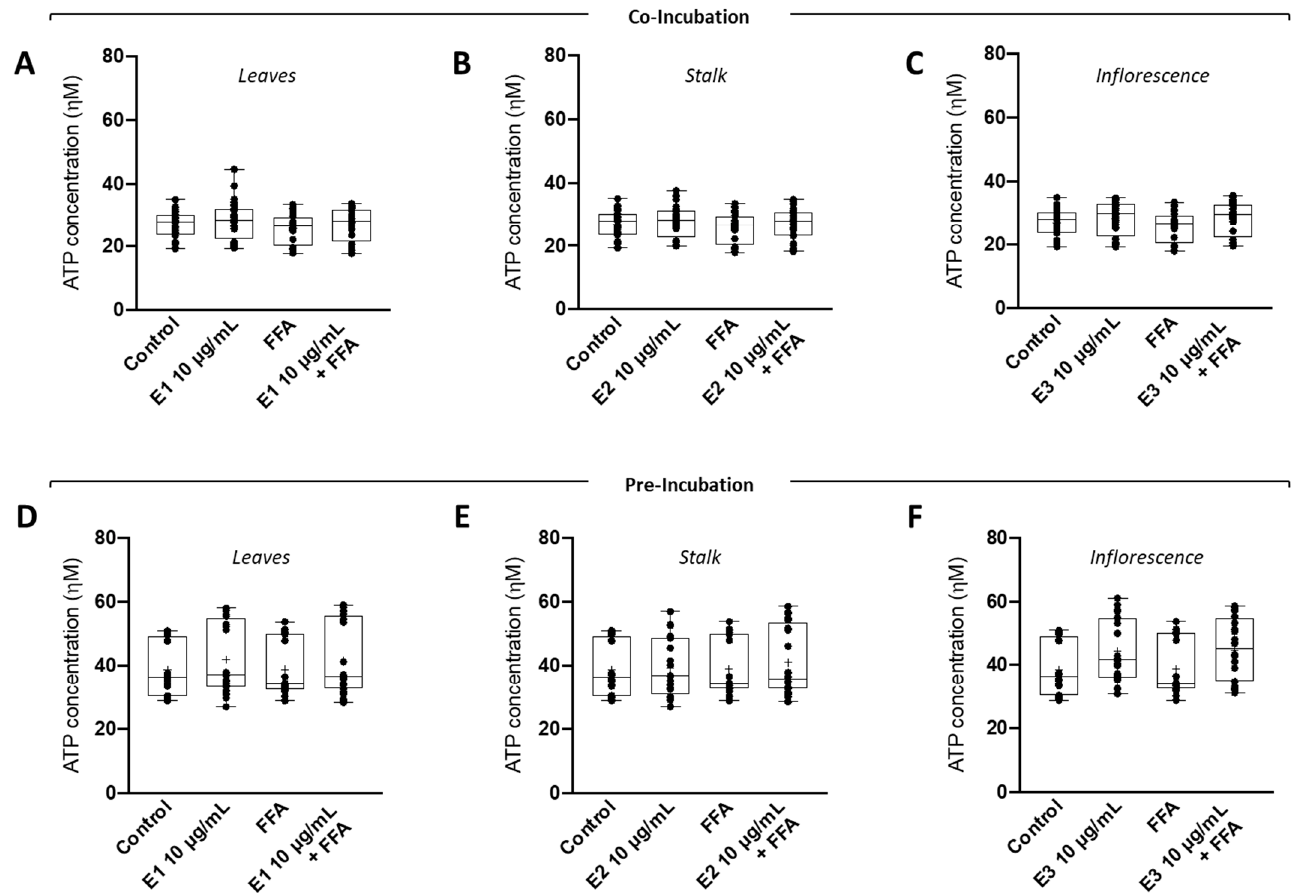
Figure 4. Effect of broccoli extracts on intracellular ATP levels under supra-physiological concentrations of fatty acids (FA) in human HepG2 cells . HepG2 cells were ( A – C ) co-incubated or ( D – F ) pre-incubated with BBP extracts (( A , D ) leaves—E1, ( B , E ) stalks—E2, or ( C , F ) inflorescences—E3) and then subjected to supraphysiological concentrations of free fatty acids. Intracellular ATP levels were measured using the CellTiter-Glo ® Luminescent Cell Viability Assay. Data are the mean ± SEM of four different assays performed, and the results were normalized on the control condition (CTL = 100%). The data obtained with BBP extracts were compared to CTL using a one-way ANOVA with Dunnett’s multiple comparison post-test.